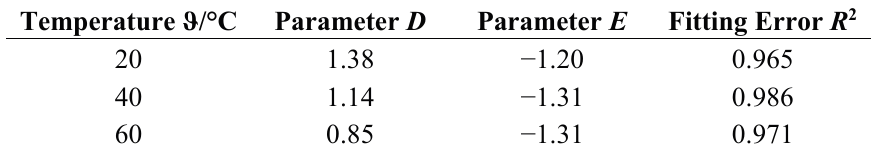
Table 4. Fitting parameters and fitting errors for characteristic time constant τ .